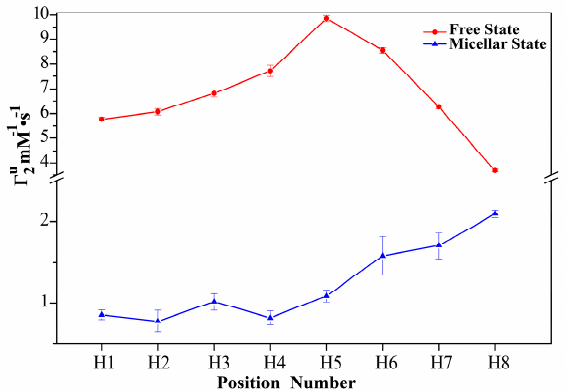
Figure 3. The 1 H sPREs of TX100 at unit concentration of the paramagnetic probe Gd (DTPA-BMA) in the free and micellar states, respectively.